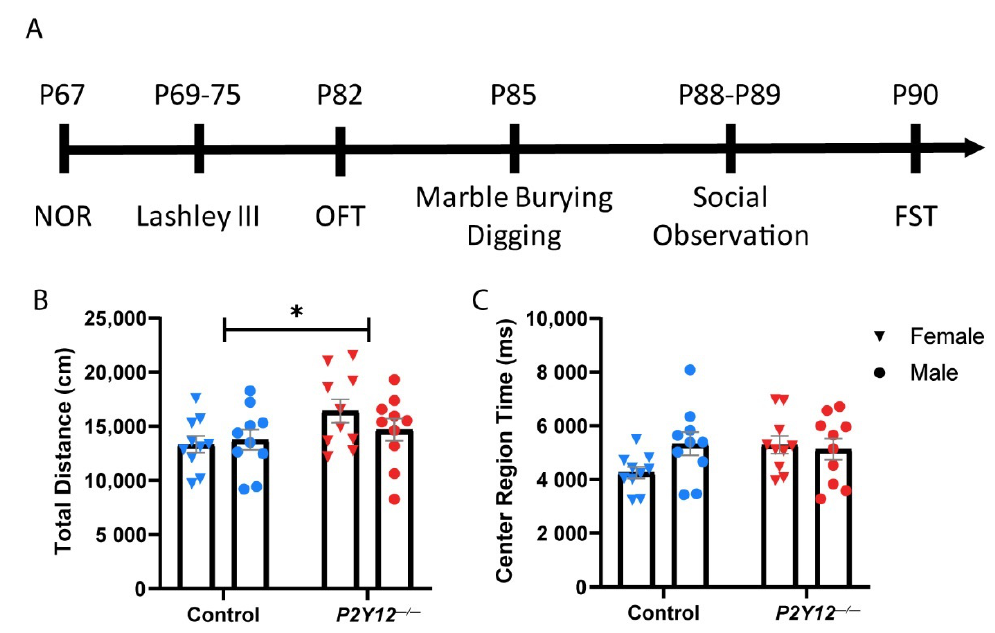
Figure 3. Behavioral testing of P2Y12 − / − mice: ( A ) timeline of behavioral testing; ( B ) P2Y12 − / − mice had a small increase in total distance traveled during the open field test; ( C ) there was no significant effect of genotype on the time spent in the center region of the open field test. ( B , C ): two-way ANOVA, Sidak post hoc, * p < 0.05; n = 20 mice per genotype (10 males, 10 females); graphs show the mean +/ − SEM.